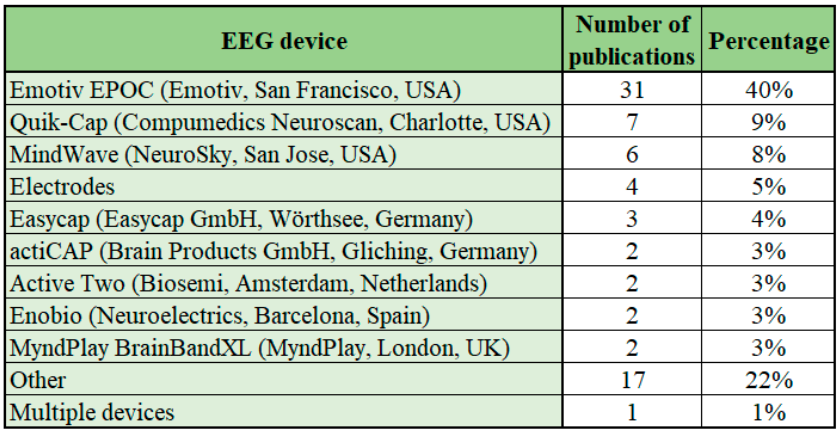
Figure 9. EEG devices used in the publications ordered by the number and percentage of publica- tions where the device has been